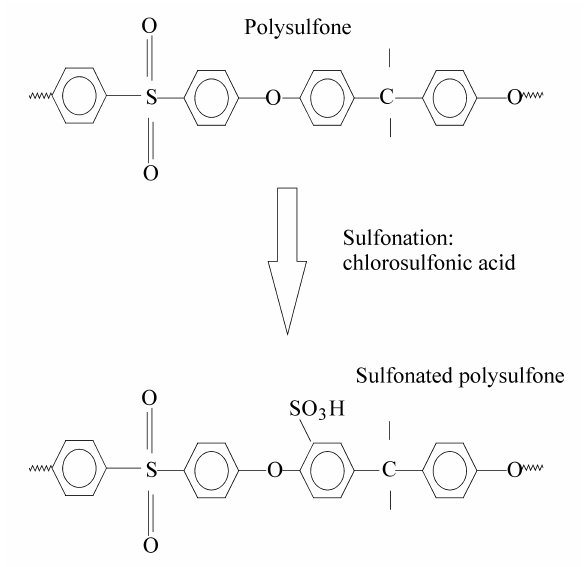
Figure 1. Sulfonation process on